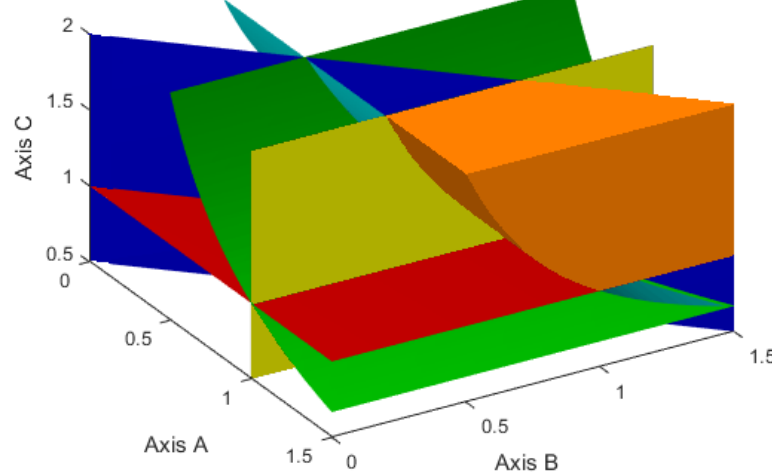
Figure 1. The orange area is the set of parameters that satisfy inequalities (54).